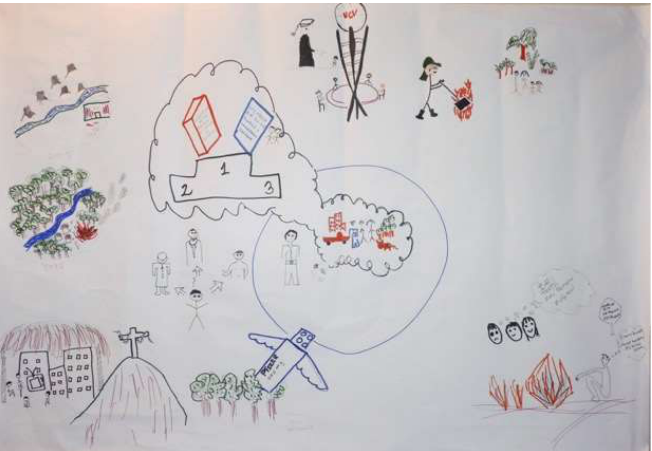
Figure 6. Rich picture drawn by members of the academic group. This group comprised researchers and students from: Universidad Simón Bolívar (USB), Universidad Central de Venezuela (UCV), Universidad Bolivariana de Venezuela (UBV, Santa Elena site), Instituto Venezolano de Investigaciones Científicas (IVIC), and Universidad Nacional Experimental Indígena del Tauca